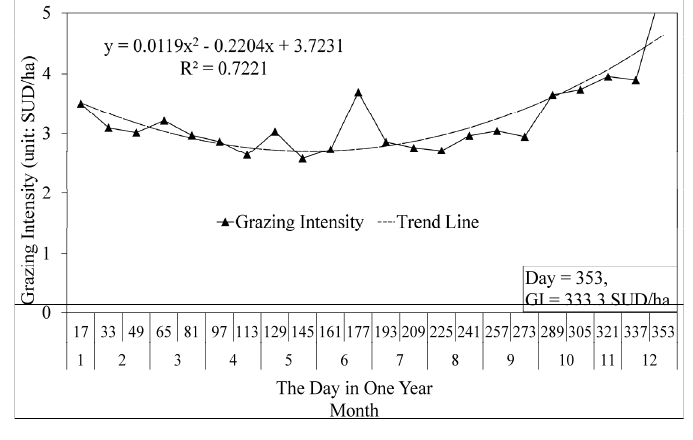
Figure 7. Average grazing intensity and its trend line of Zoige County in 2012.